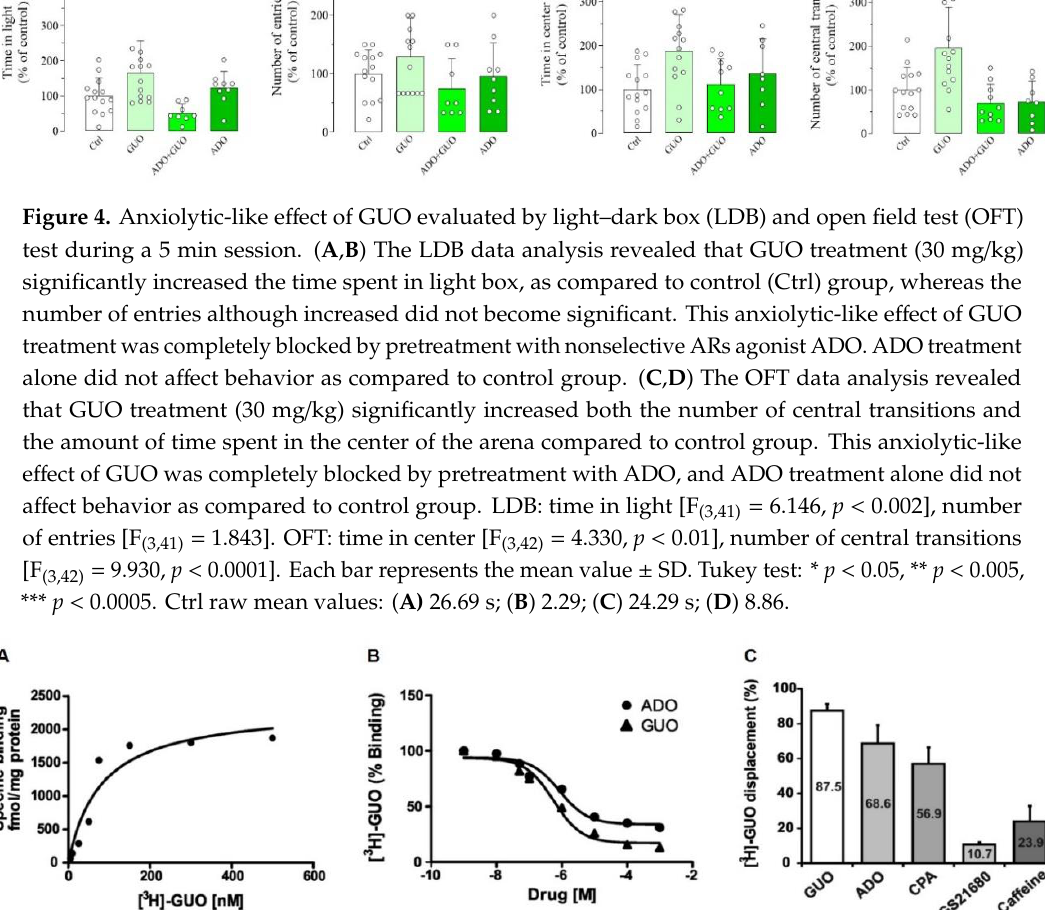
Figure 5. [ 3 H]GUO binding to hippocampal membranes. ( A ) The saturation isotherm studies showed that the binding became saturable at [ 3 H]GUO concentrations ranging between 100 and 300 nM. The pooled data resolved for the presence of a single high affinity binding site with an apparent K D = 80 ± 34 nM; B max = 2339 ± 339 fmol/mg /protein. ( B ) Displacement of [ 3 H]GUO binding by GUO and nonselective ARs agonist ADO in rat hippocampal membranes. Competition binding between GUO and ADO showed for ADO almost the same potency order of GUO to displace [ 3 H]GUO (pIC 50 6.069 ± 0.2074 and pIC 50 − 6.251 ± 0.1649, respectively), although ADO was able to displace only 70% of [ 3 H]GUO binding. ( C ) [ 3 H]GUO displacement (70 nM) by 500 µM of GUO, ADO, caffeine and selective agonists CPA or CGS21680 in rat hippocampal membranes.ADO was almost as effective as GUO in displacing [ 3 H]GUO binding. Selective A 1 R agonist CPA or selective A 2A R agonist CGS21680 displaced respectively 57% and 11% of [ 3 H]GUO binding. Nonselective ARs antagonist caffeine displaced only 24% of [ 3 H]GUO binding.